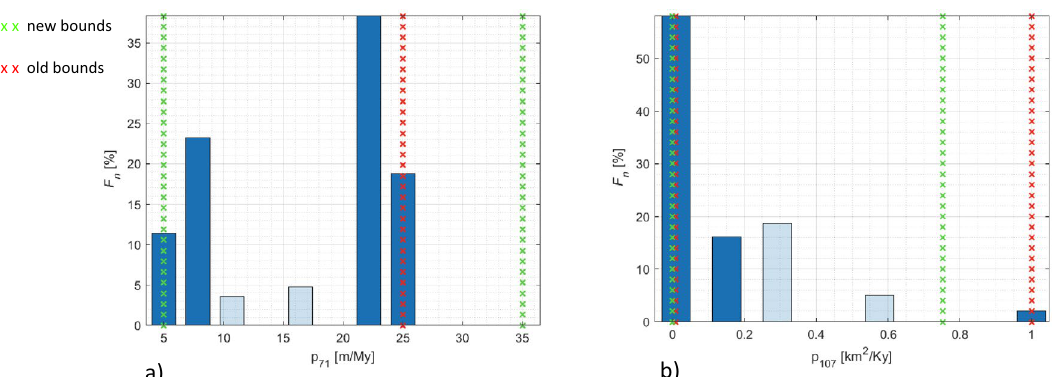
Figure 7. Distribution of the parameters #71( a ) and #107 ( b ) delimited by red crosses together with the new intervals (green crosses) in the first step of the